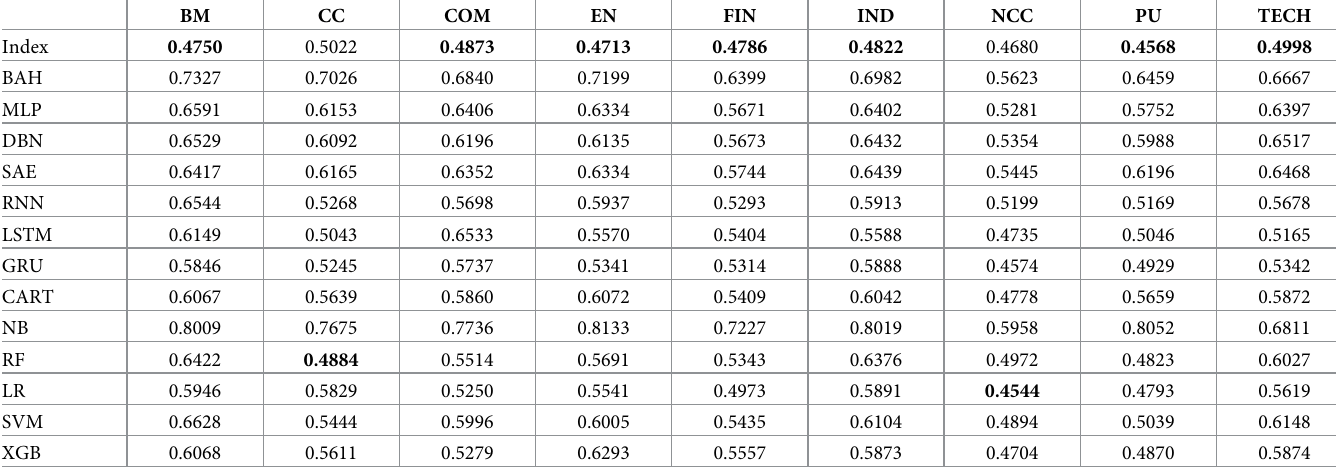
Table 11. Comparison of the MDD of various trading strategies in the different industries of CSICS. Best performance is in